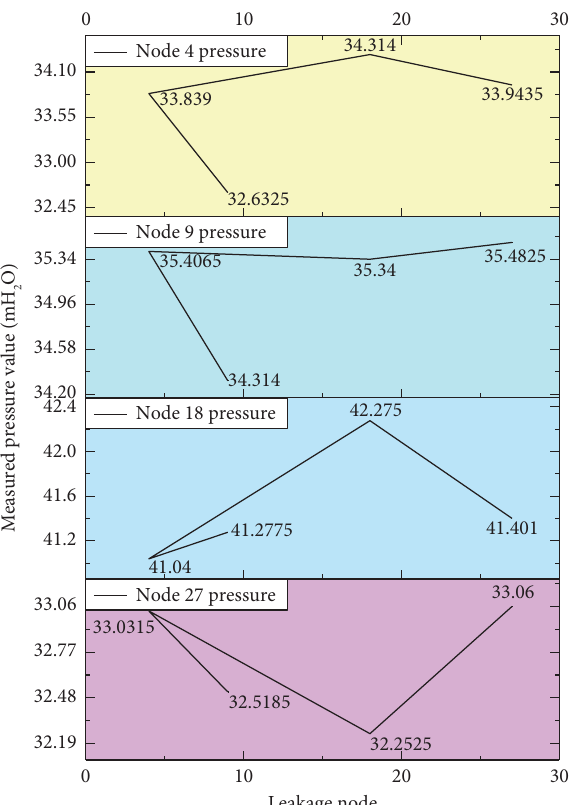
Figure 4: Te measured value of the pressure at the leakage measuring